Question: What style of plot is this figure drawn as?
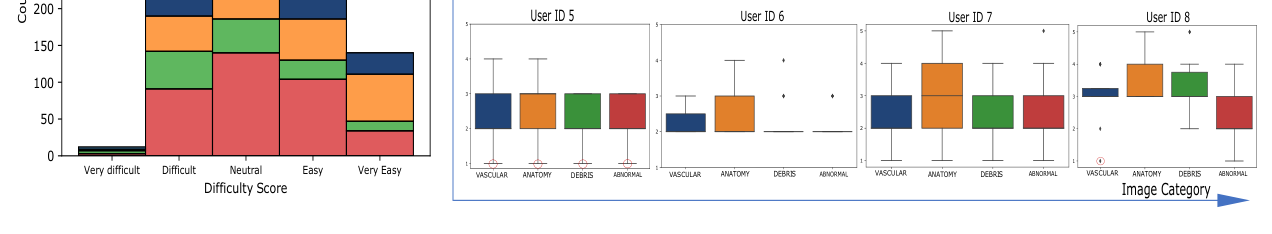
Answer: box